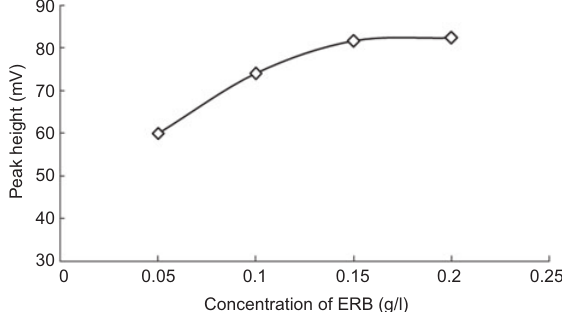
Figure 3 Effect of injection volume.